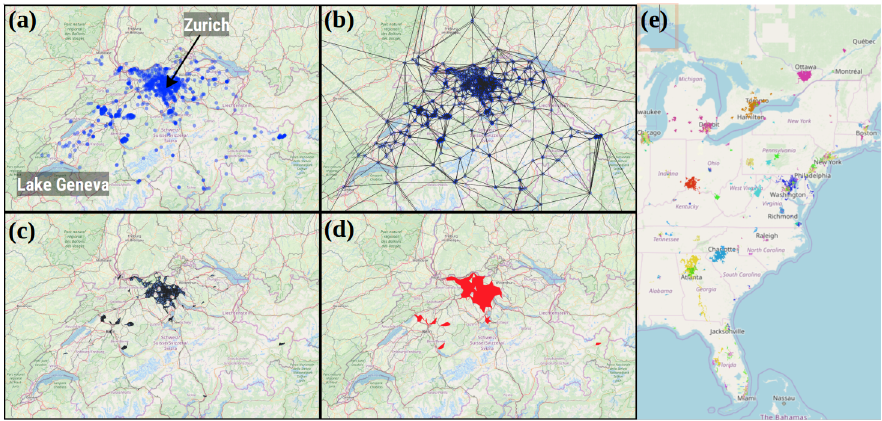
Figure 5. Reconstructing home regions. ( a ) Changeset centroids; ( b ) Delaunay triangles constructed from changeset centroids; ( c ) exclusion of triangles with large perimeters, and ( d ) final activity area after merging triangles and excluding continuous areas with only few changesets; ( e ) activity areas of fixer users in the eastern part of the United States and